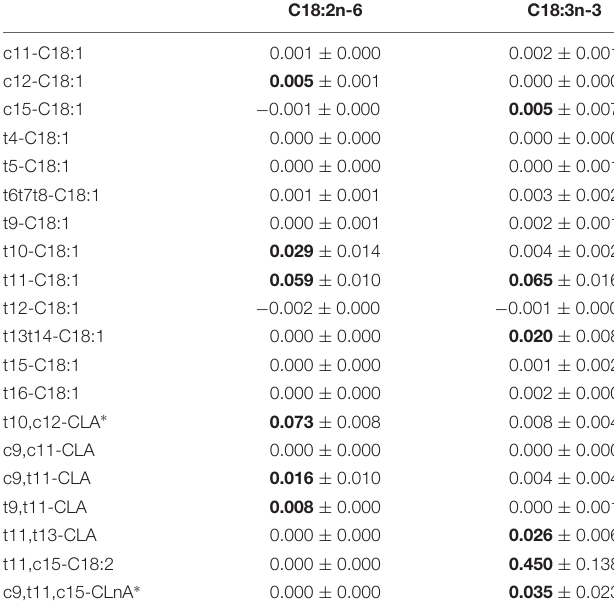
TABLE 2 | Amount (mg) of biohydrogenation intermediates produced after 3 h incubation with 1 mg of C18:2n-6 or C18:3n-3 in an enzymatic solution obtained from a cow’s ruminal content (mean ± SD, Experiments 1.1 and